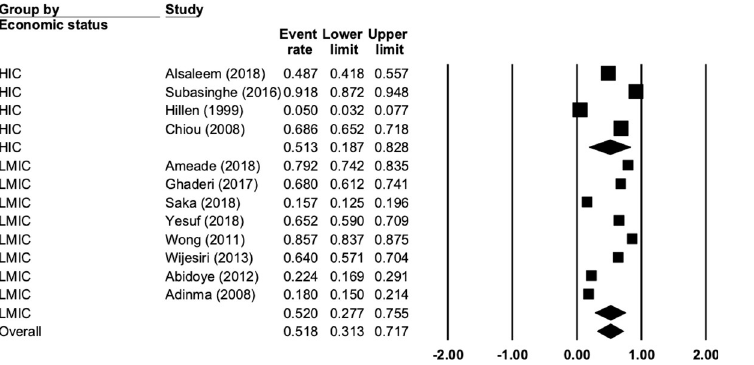
Fig 4. Complementary, traditional or non-pharmacological